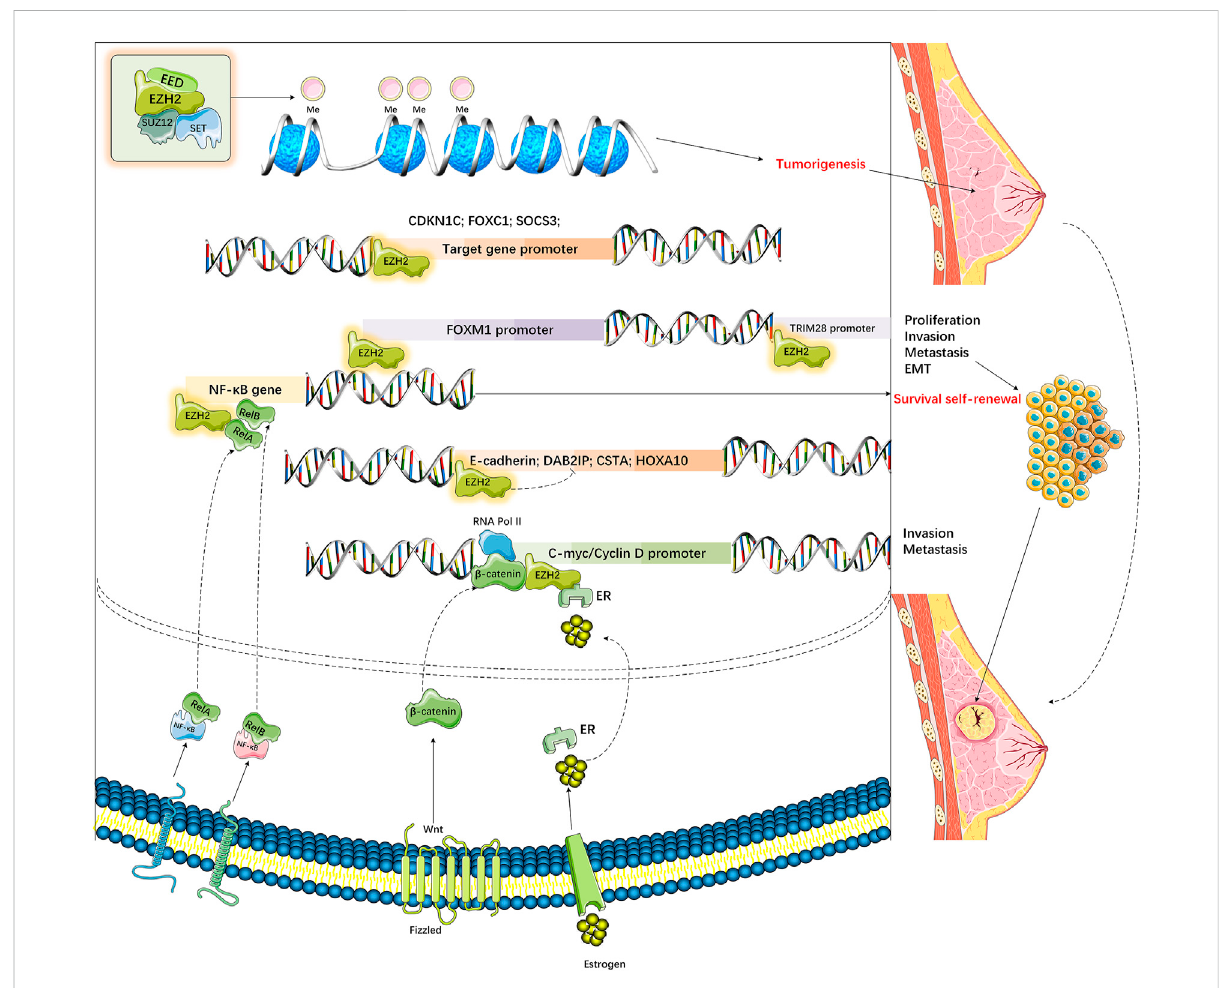
FIGURE 3 Dysregulation of EZH2 in various breast